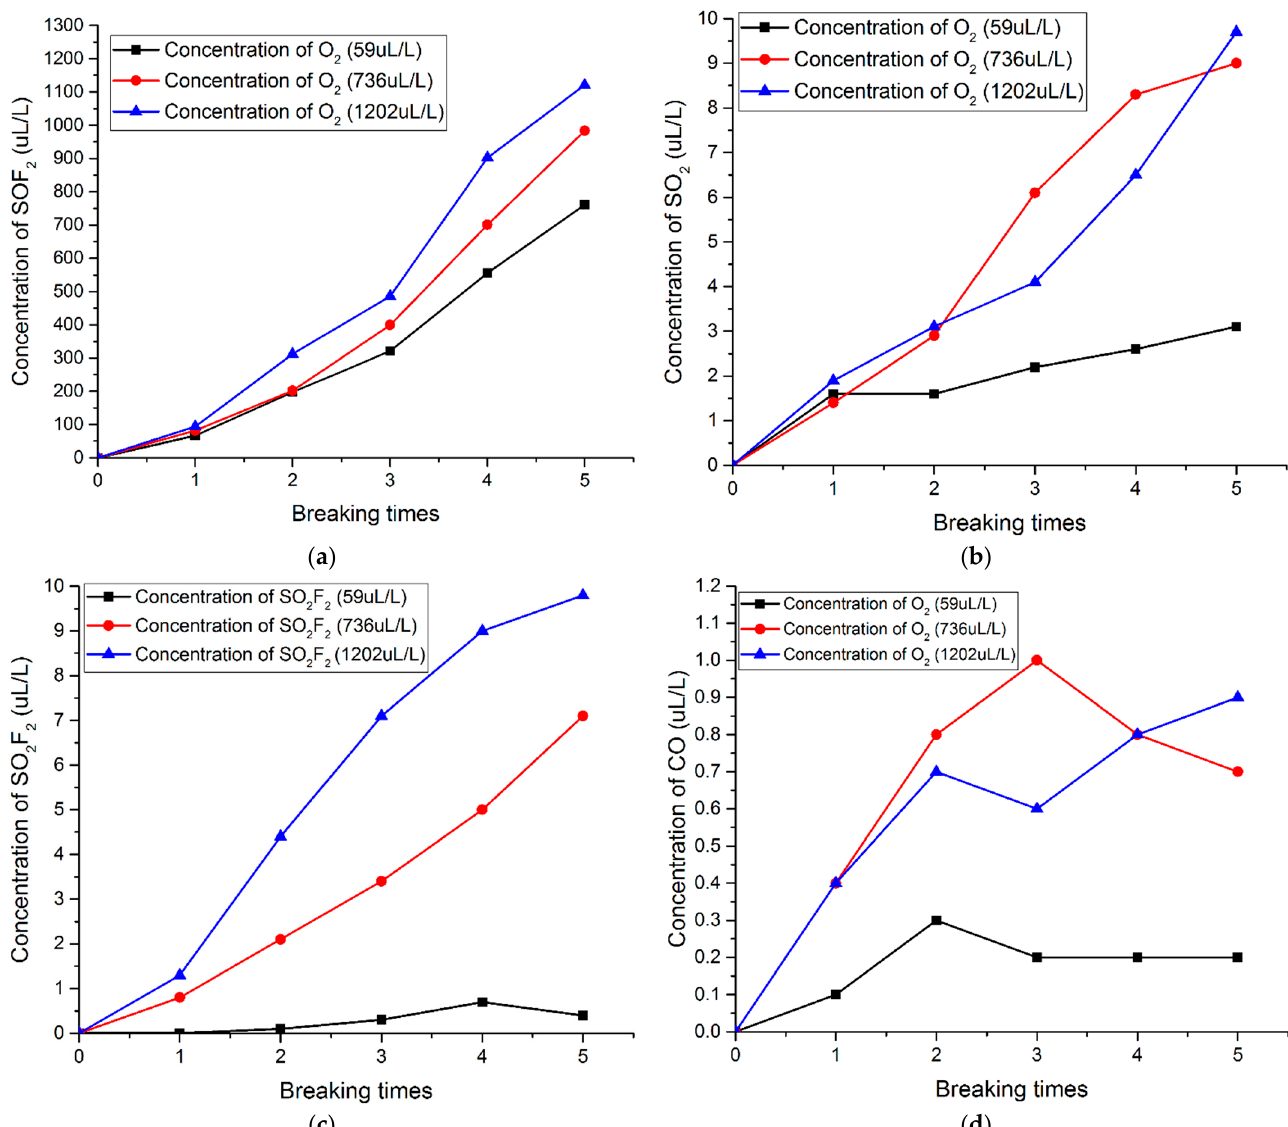
Figure 8. Changes of SOF 2 , SO 2 , SO 2 F 2 , and CO concentrations with the breaking times under different O 2 concentration. ( a ) Changes of SOF 2 with the breaking times. ( b ) Changes of SO 2 with the breaking times. ( c ) Changes of SO 2 F 2 with the breaking times. ( d ) Changes of CO with the breaking times.